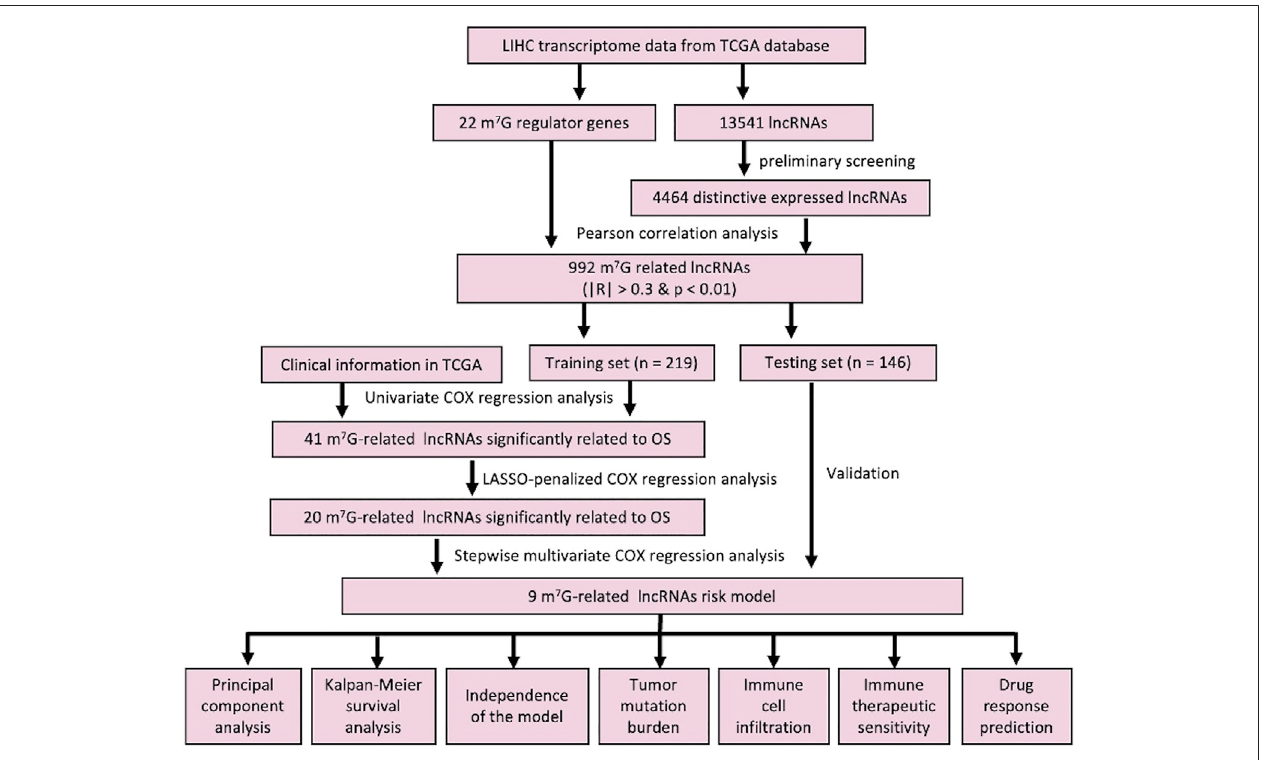
FIGURE 1 | Detailed work fl ow of this